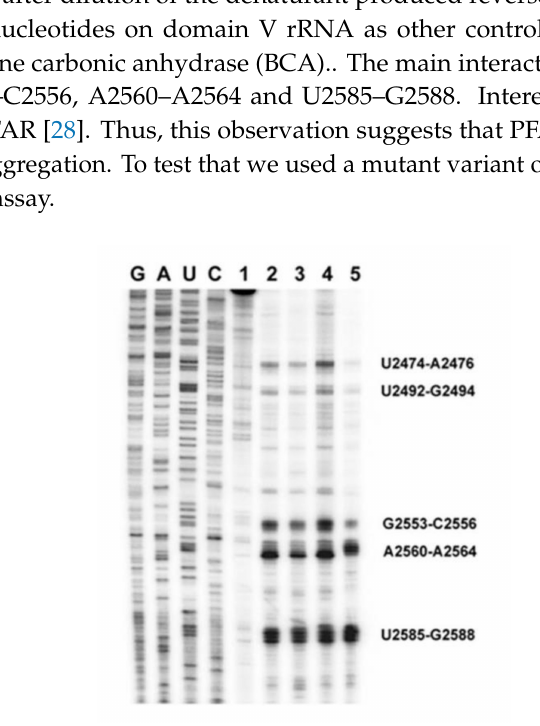
Figure 5. Primer extension or “road-block” analysis of domain V of 23S rRNA after UV cross-linking of HET-s and other protein while refolding. HET-s and three other protein controls were subjected to UV cross-linking with domain V of 23S rRNA E. coli immediately after dilution from the denaturant as mentioned in the Materials and Methods. Then, primer extension was performed using reverse transcriptase and the products were run on a sequencing gel—without any protein ( Lane 1 ), with HCA ( Lane 2 ), DHFR ( Lane 3 ), BCA ( Lane 4 ) and HET-s ( Lane 5 ). The first four lanes in the left show sequencing ladders as indicated on top. The road-block sites are labeled with nucleotide numbers corresponding to E. coli 23S rRNA. Part of this gel was originally published in the Journal of Biological Chemistry [28]. © the American Society for Biochemistry and Molecular